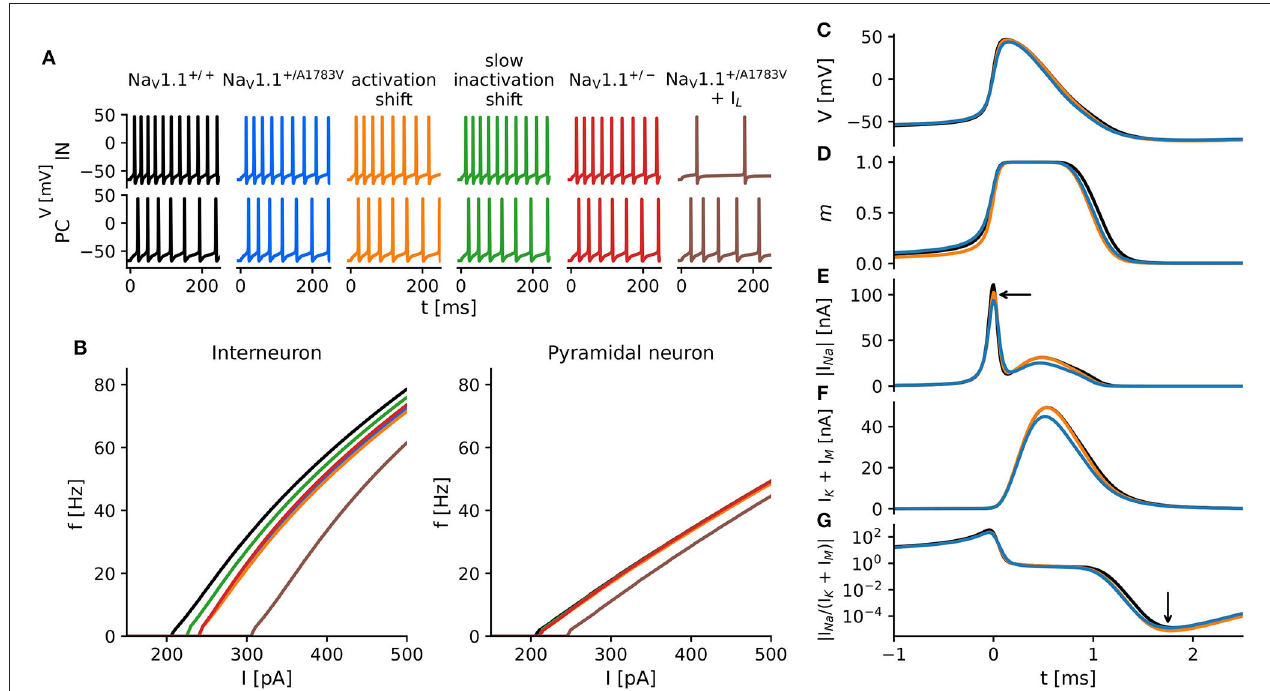
FIGURE 2 | In silico modeling of neuron excitability. (A) Action potentials of simulated cortical fast-spiking interneurons (upper traces) and cortical pyramidal cells (PCs) (lower traces) in response to square pulse current injections of 320 pA with various modifications of Na V 1.1 current kinetics based on findings in tsA recordings. Colors indicate different model conditions: WT (black), the heterozygous shift of the voltage-dependence of steady-state activation (orange), the heterozygous shift of the voltage-dependence of the steady-state slow inactivation (green), the combination of both changes (blue), a heterozygous protein knockout (red), and a combination of respective changes in sodium current and a decreased input resistance of the cell (brown). The exact parameters for all simulated conditions are summarized in Table 1 . (B) f - I curves of interneurons (left) and PCs (right) constructed from simulation studies displayed in (A) . (C–G) Time courses of model variables during the first action potential after a 300pA current injection, t = 0 indicates the peak of the action potential. (C) Membrane voltage; (D) activation gate m —ratio of activated sodium channels; (E) absolute I Na ; (F) I K ; and (G) the absolute ratio of I Na to I K